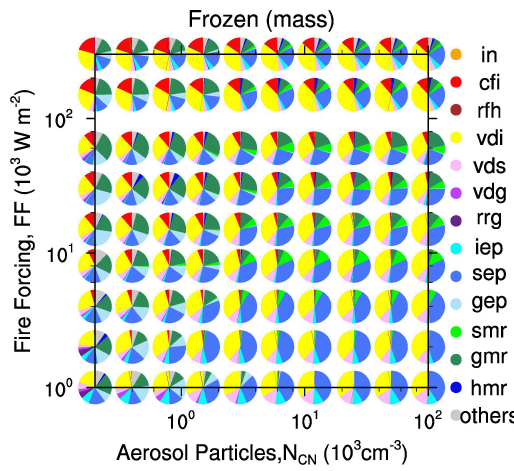
Figure 20. Same as Fig. 16 but for the total frozen water con- tent. Abbreviations are as follows: in, ice nucleation; cfi, freezing of cloud droplets to form ice crystals, including homogeneous and heterogeneous nucleation; rfh, freezing of raindrops to form hail; vdi/s/g, condensational growth of ice crystals/snow/graupel by wa- ter vapor; rrg, riming of raindrops to form graupel; i/s/gep, evapo- ration of ice/snow/graupel; s/g/hmr, melting of snow/graupel/hail to form